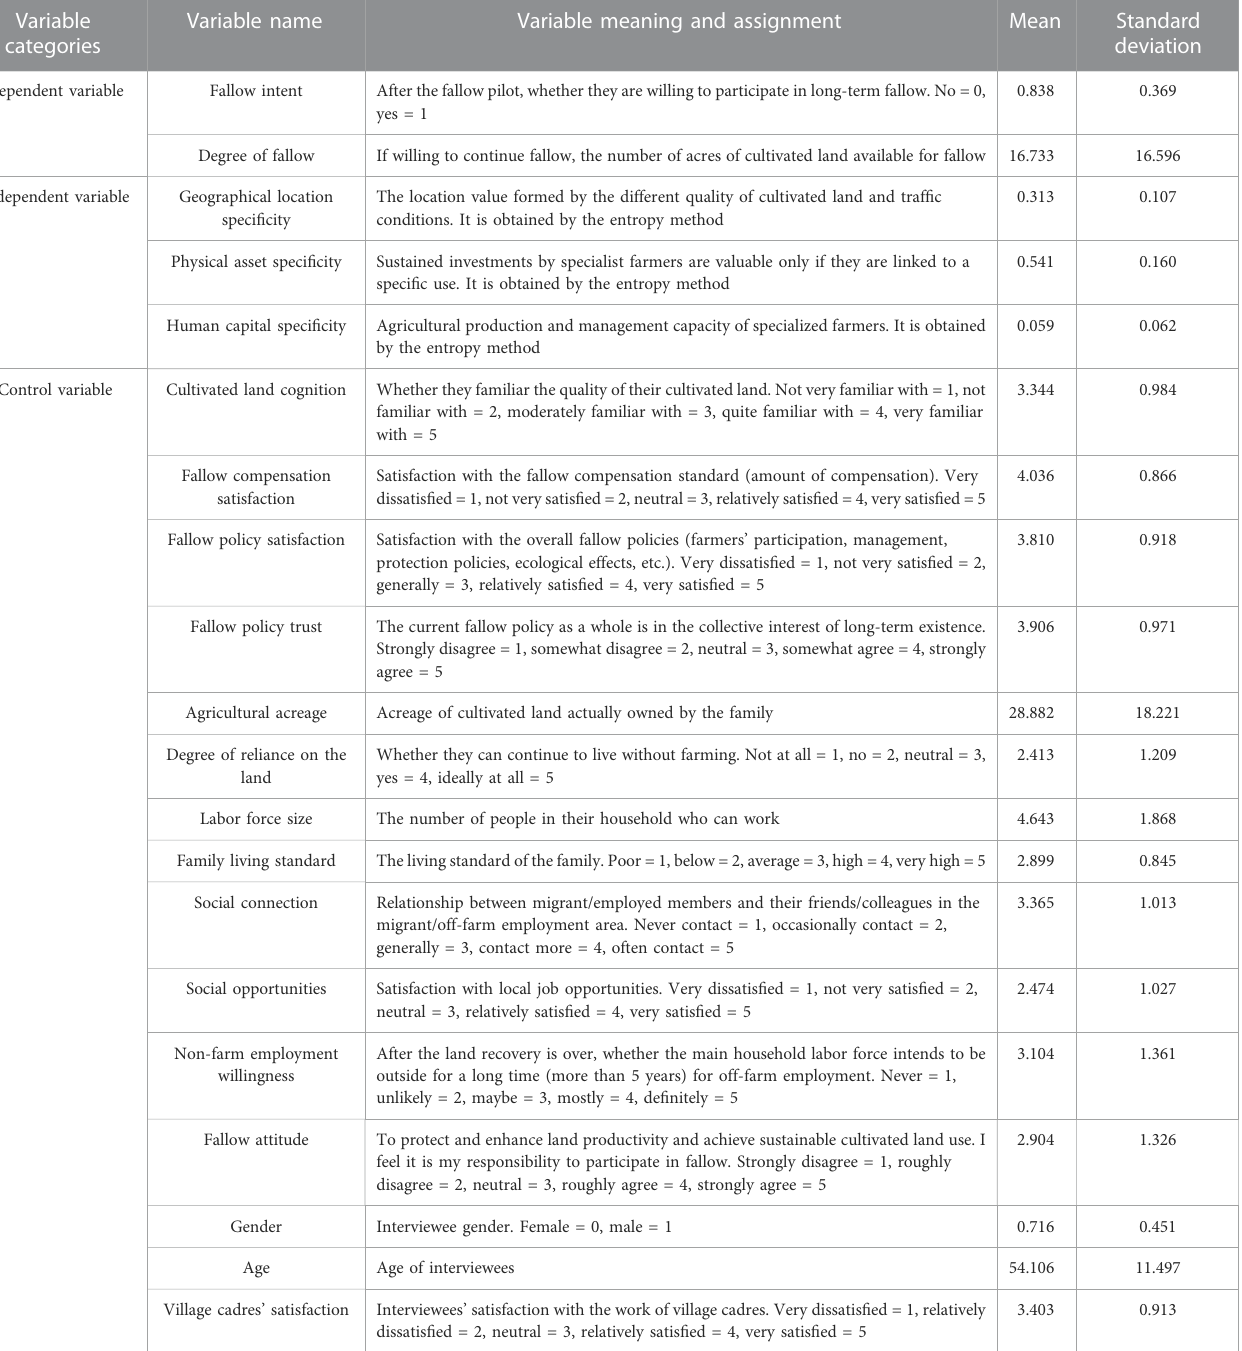
TABLE 5 Meaning of variables and their descriptive statistics for fallow